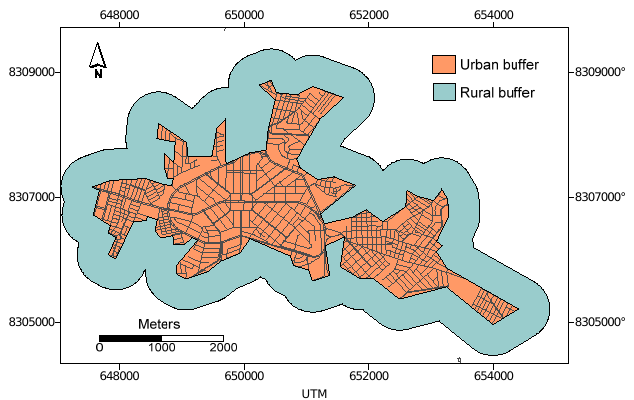
Figure 2. Delimitation of the urban and rural buffer.